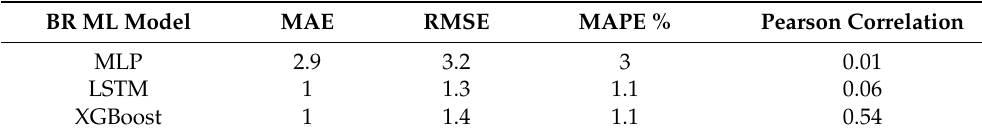
Table 6. Testing Performance Results of the SpO2 ML